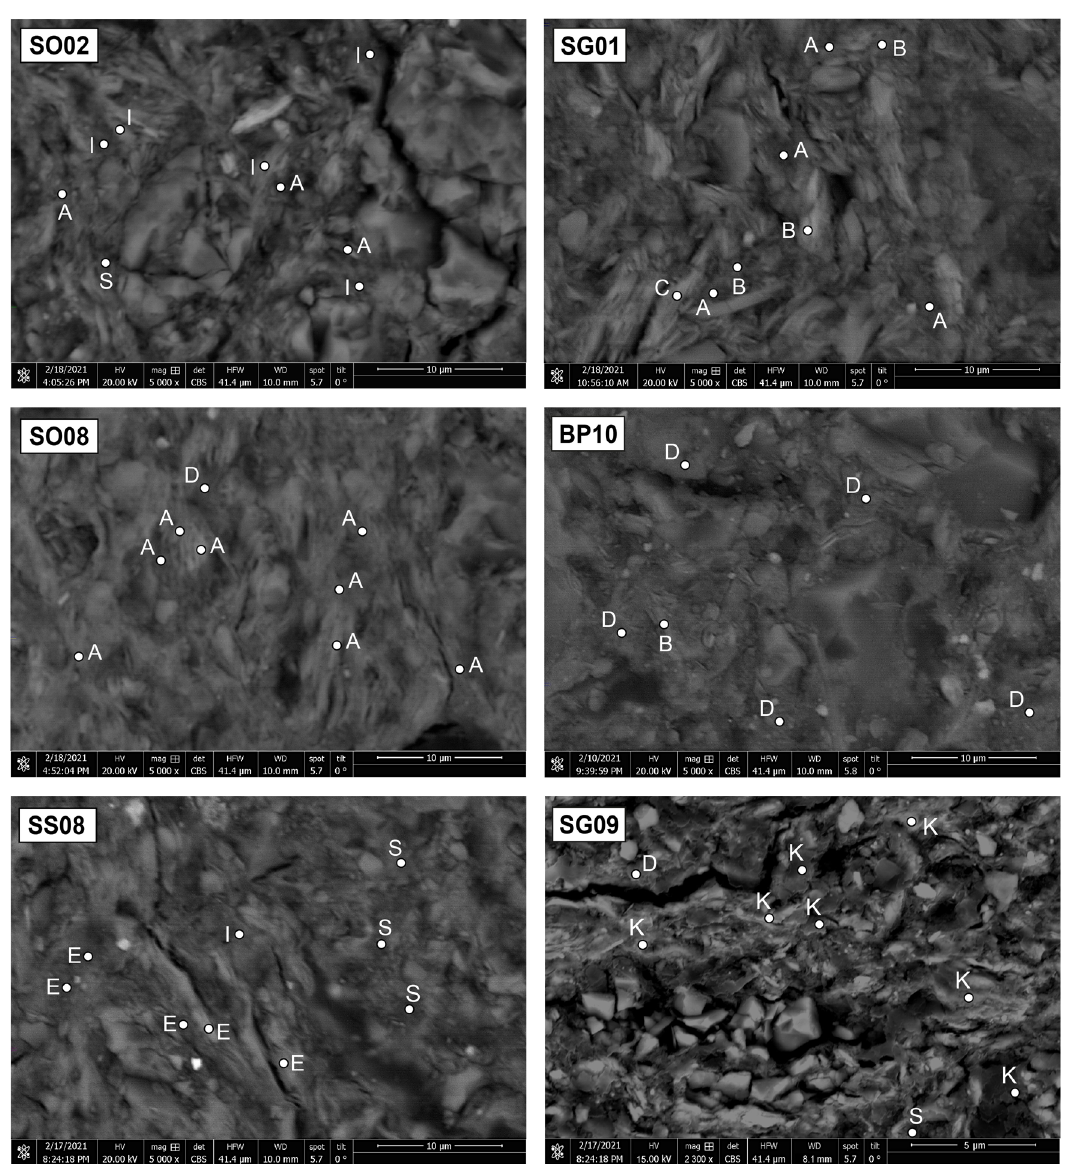
Figure 6: Backscattered images of selected ceramic matrix. Exemplary EDS spectra ( A, B, C, IL, etc. ) may be found in Table